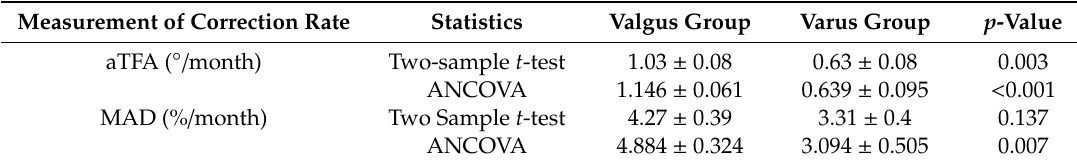
Table 3. Comparison of correction rates between valgus and varus groups: Before and after adjustment by